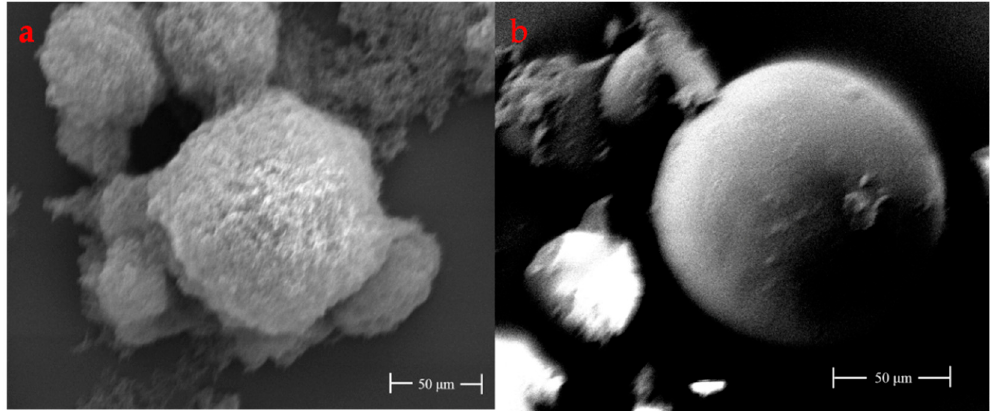
Figure 3. SEM images of MIPs ( a ) and non-molecularly imprinted polymers (NIPs) ( b ).